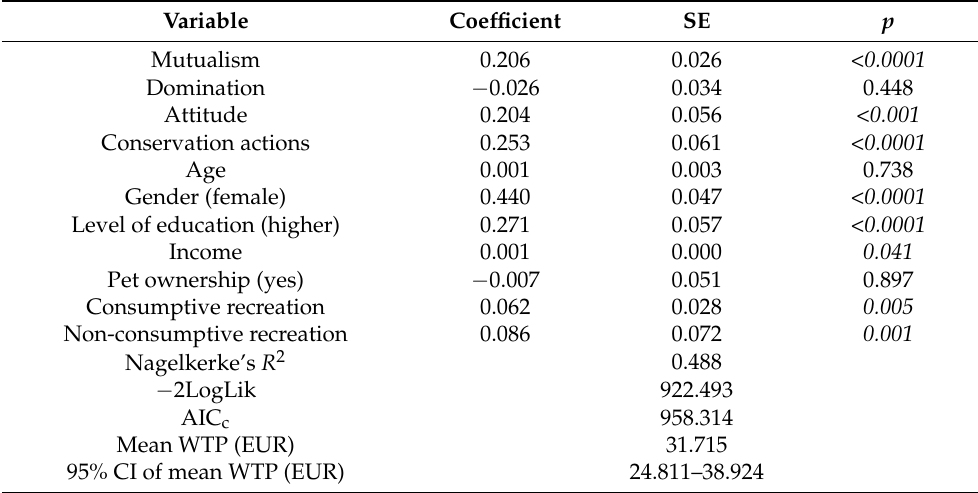
Table 6. Interval regression willingness to pay model (highest yes/lowest no bids, n =